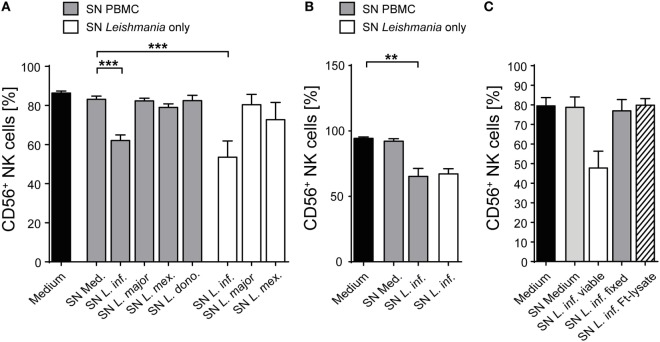
Supernatants (SNs) from peripheral blood mononuclear cell (PBMC)/Leishmania infantum cocultures downmodulate CD56 expression on natural killer (NK) cells. SNs from PBMC/Leishmania cocultures (multiplicity of infection 10) or from pure Leishmania cultures were used at a concentration of 60% (vol/vol) to stimulate (A,C) PBMCs or (B) purified NKp46+/CD3− NK cells for 20 h. CD56 surface expression on NKp46+/CD3− NK cells was determined by flow cytometry. (A) Mean ± SEM of 61 (medium), 59/59/53/50/15 (SN PBMC/Leishmania-coculture), or 8/8/6 (SN Leishmania only) donors. (B) Mean ± SEM of eight (medium), eight (SN PBMC/Leishmania-coculture), or two (SN Leishmania only) donors. (C) Mean ± SEM of 8/8/8/7/5 donors for the five stimulations. **p < 0.01; and ***p < 0.001 two-tailed Mann–Whitney U test.